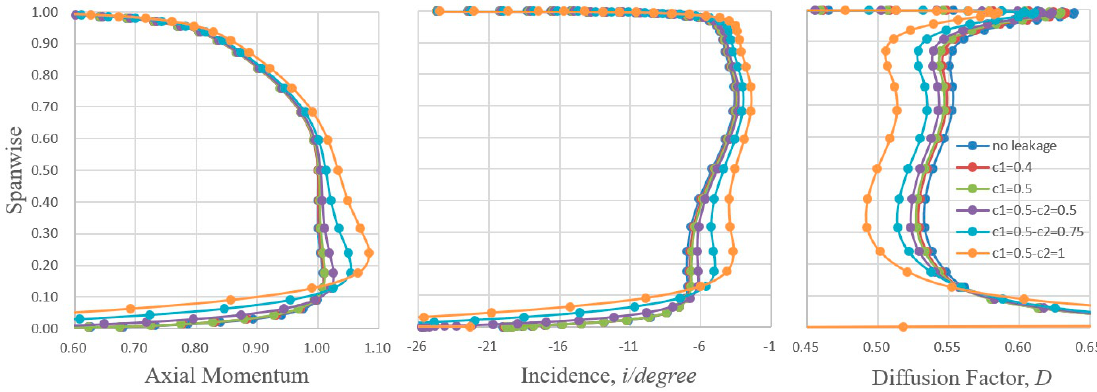
Figure 16. Spanwise distribution of blade element performance for Rotor 3.